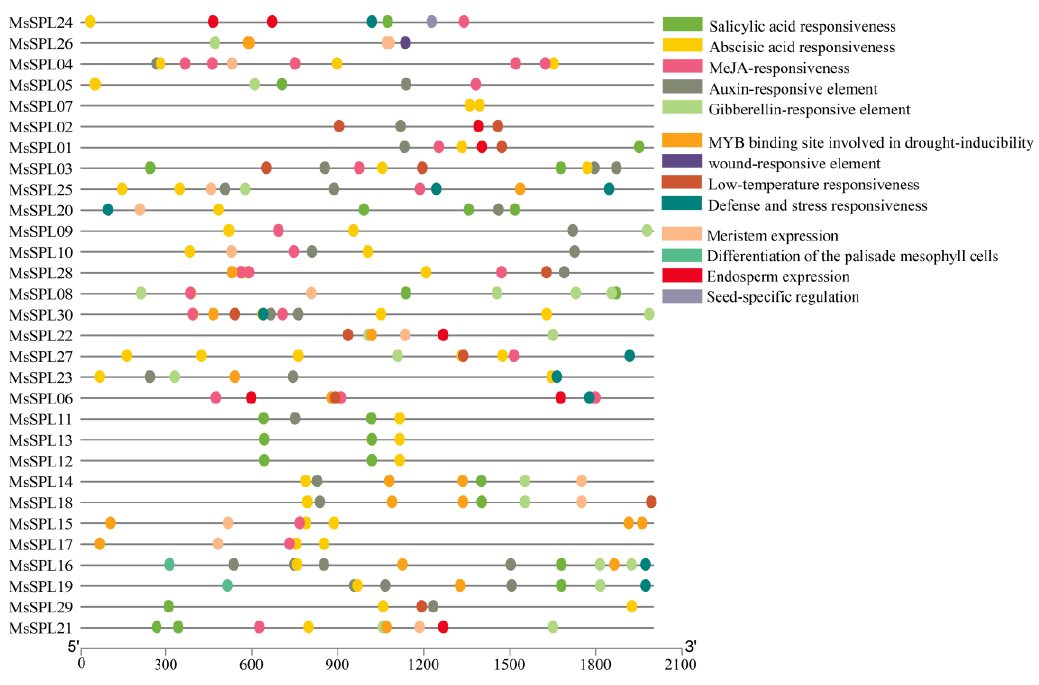
Figure 7. The cis -elements identify. The 2000 bp promoter sequences of MsSPL were analyzed by PlantCARE.